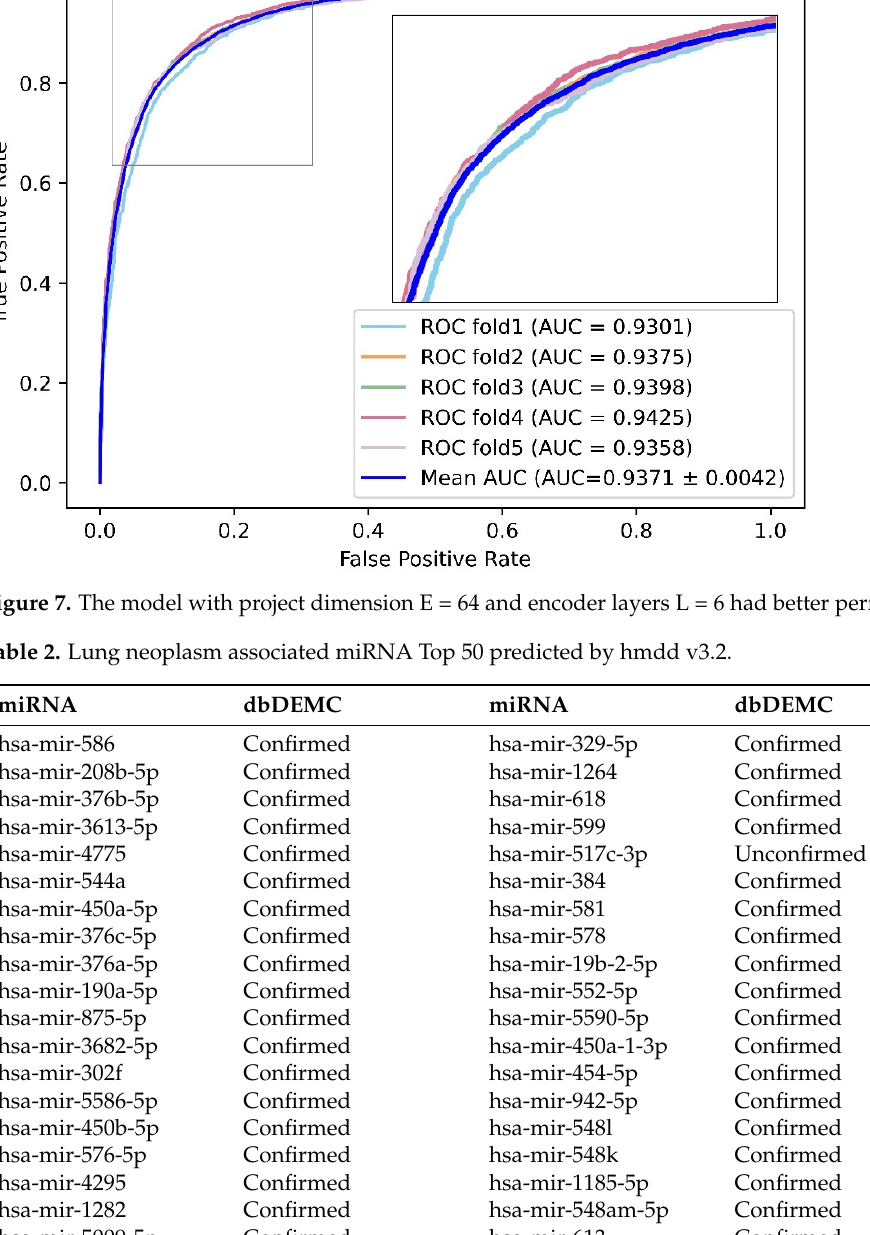
Table 1. Comparative analysis of our model and related models.